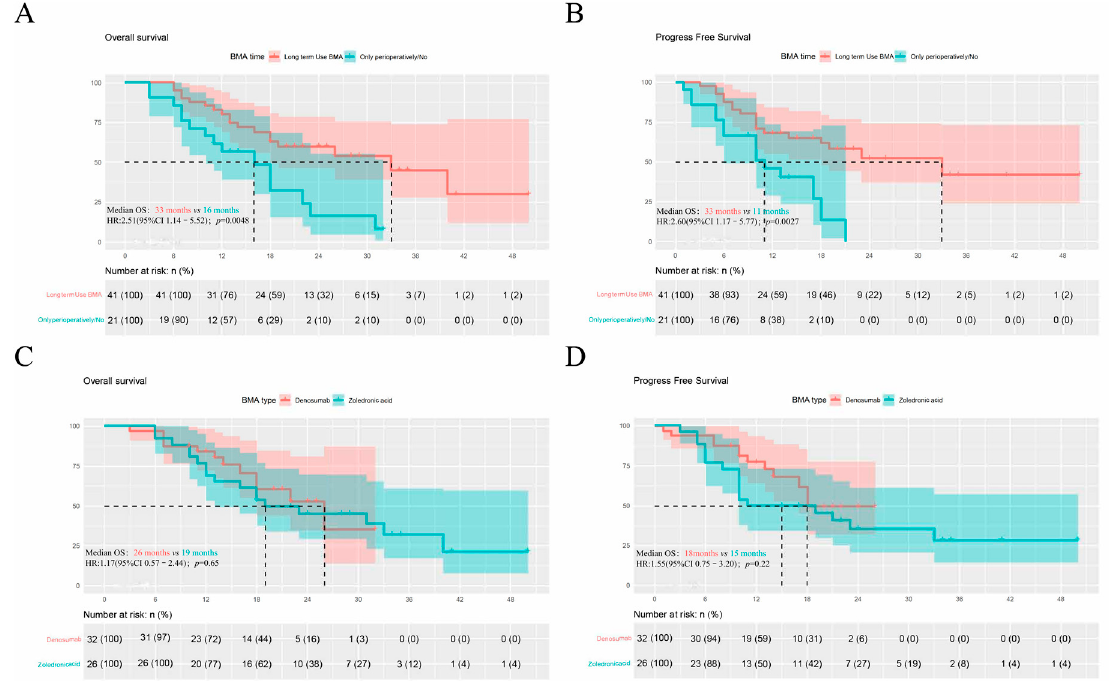
Figure 2. Kaplan–Meier curve of overall and progression-free survival: ( A ) Overall survival for using BMA in the long term and only using it perioperatively, or not at all; ( B ) Progression-free survival for using BMA in the long term and only using it perioperatively, or not at all; ( C ) Overall survival for ZA and denosumab groups; and ( D ) Progression-free survival for ZA and denosumab groups.